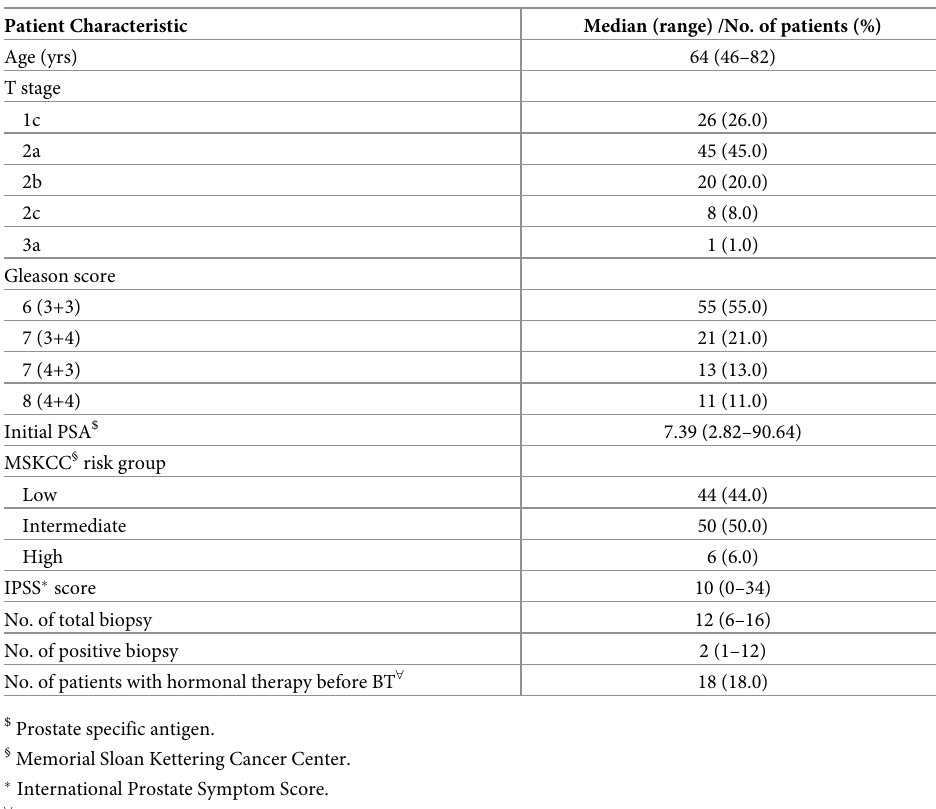
Table 1. Patient